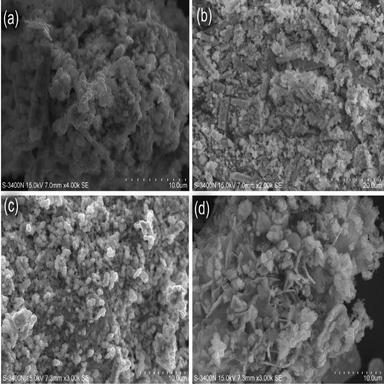
SEM images of syntheized Bi2Se3 nanostructures – a)Coprecipitation – without capping b) Coprecipitation – with capping c) hydrothermal – without capping d) Hydrothermal – with capping.